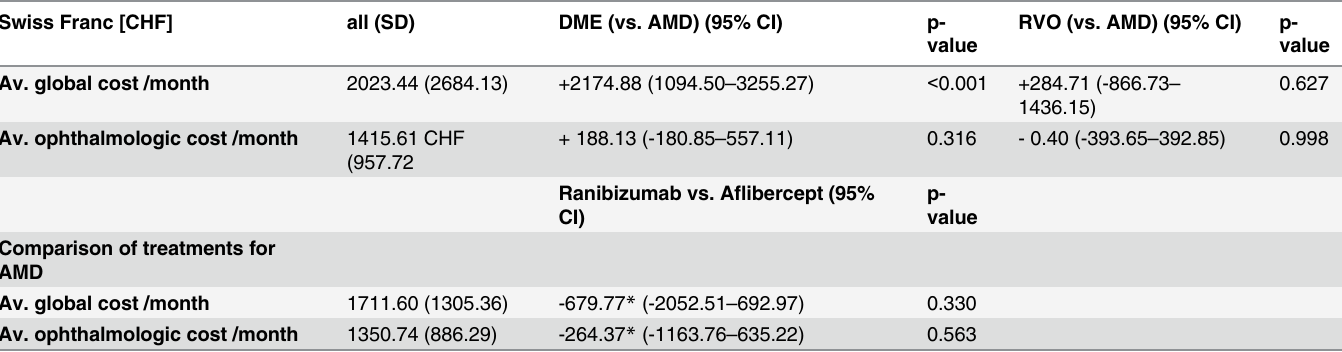
Table 1. Summary of cost for patient group and type of treatment. Swiss Franc [CHF] all